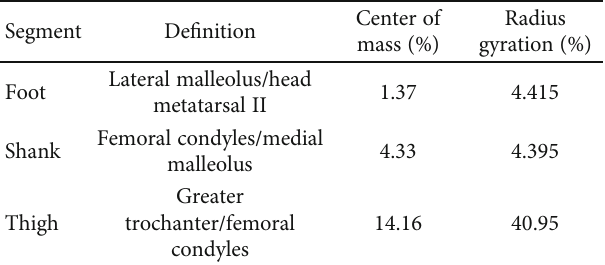
Table 2: Anthropometric